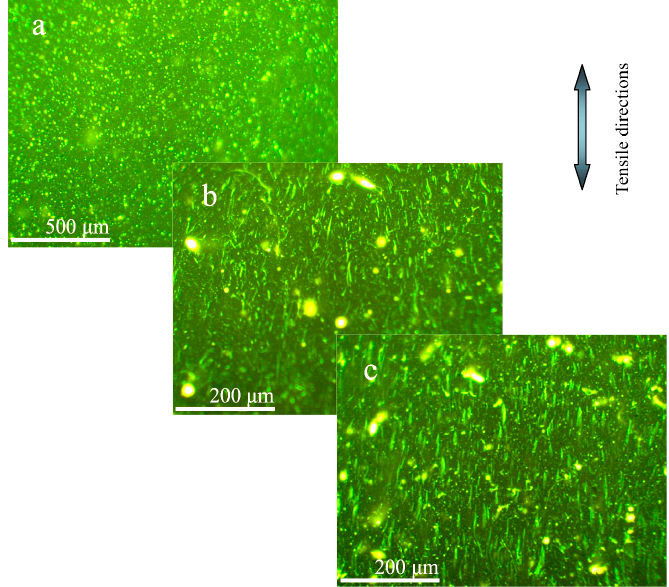
Figure 11. Fluorescence microscopy morphologies of microcapsules/bitumen sample (bitumen, 40/50; microcapsule, 20 μ m, 3.0 wt. %) of ( a ) original; ( b ) after going through the healing cycle once and ( c ) going through the healing cycle twice.